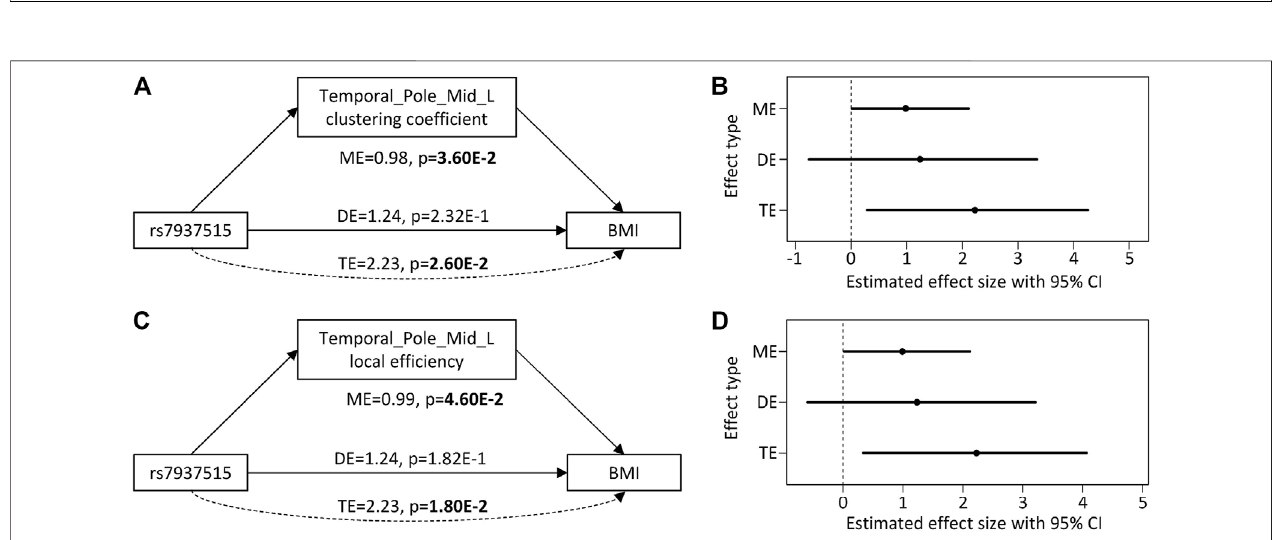
FIGURE5| Directandmediationeffectofrs7937515onBMIthroughleftmiddletemporalgyrus. (A,B) illustratetheeffectsize,95%CIand p valuefromrs7937515 mediation analysis of BMI via left middle temporal clustering coef fi cient. (C,D) illustrate the effect size, 95% con fi dence interval and p value from rs7937515 mediation analysis of BMI via left middle temporal local ef fi cient. TE (cid:1) total effect; DE (cid:1) direct effect; ME (cid:1) mediation effect; CI (cid:1) con fi dence interval.